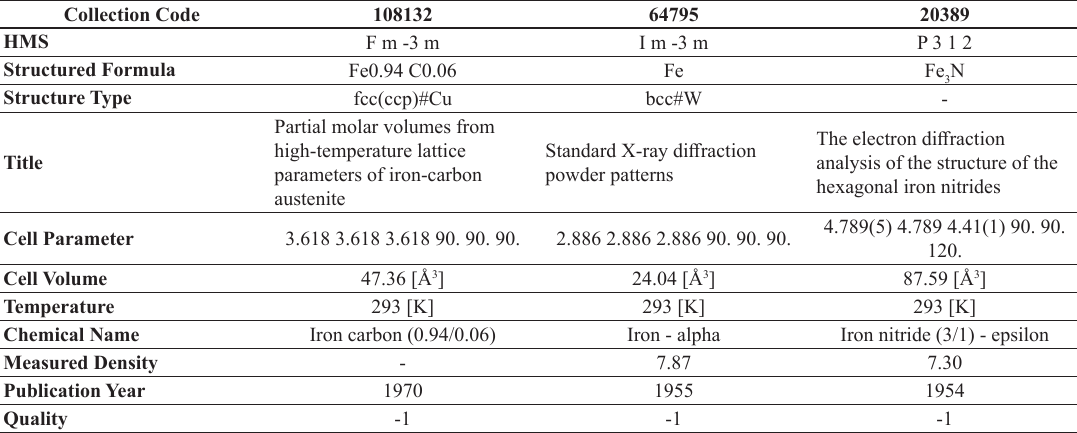
Table 4. Crystallographic cards database [ICSD database 33